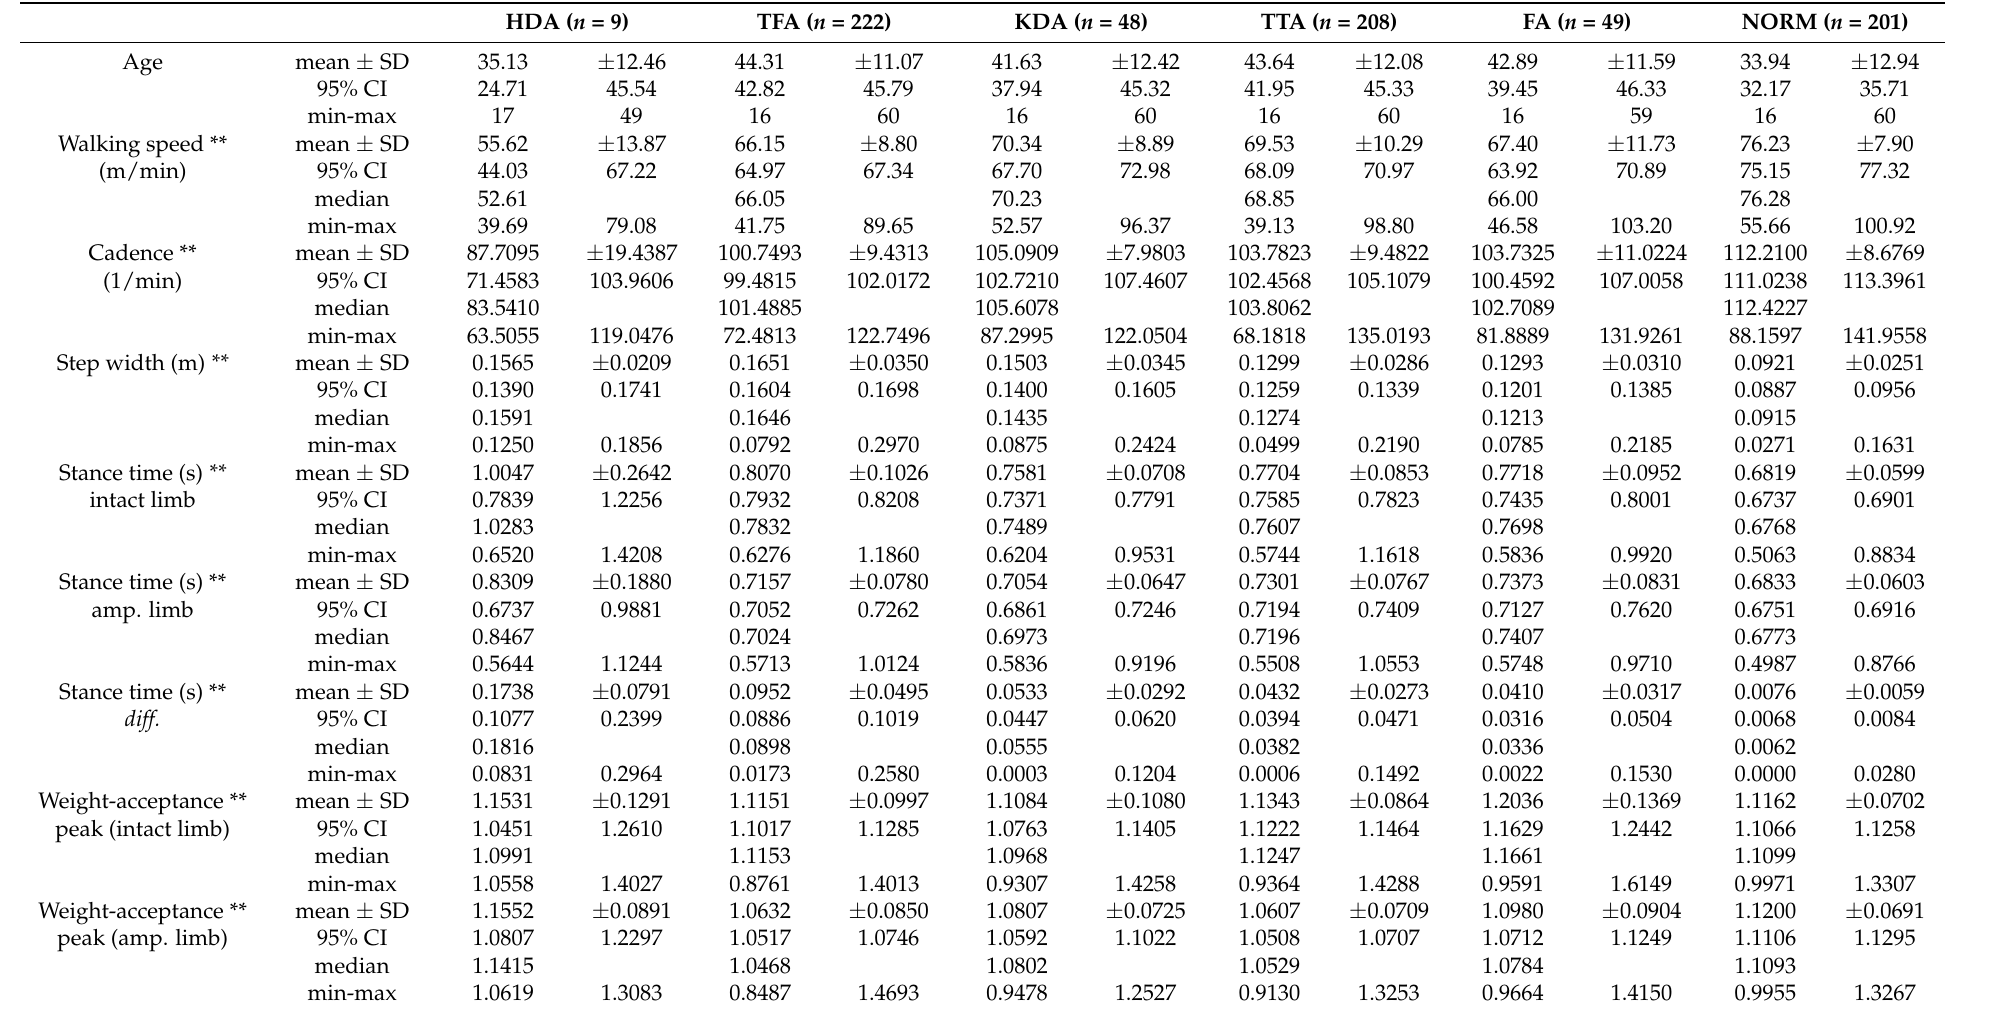
Table 2. Reference values for kinetic gait parameters in unilateral lower limb amputations and physiological gait (age: 16–60